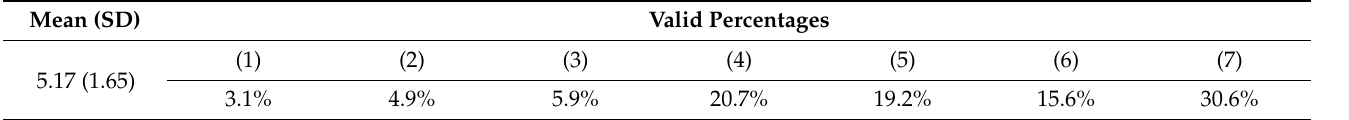
Table 3. LBW Visitors’ Intention-to-return